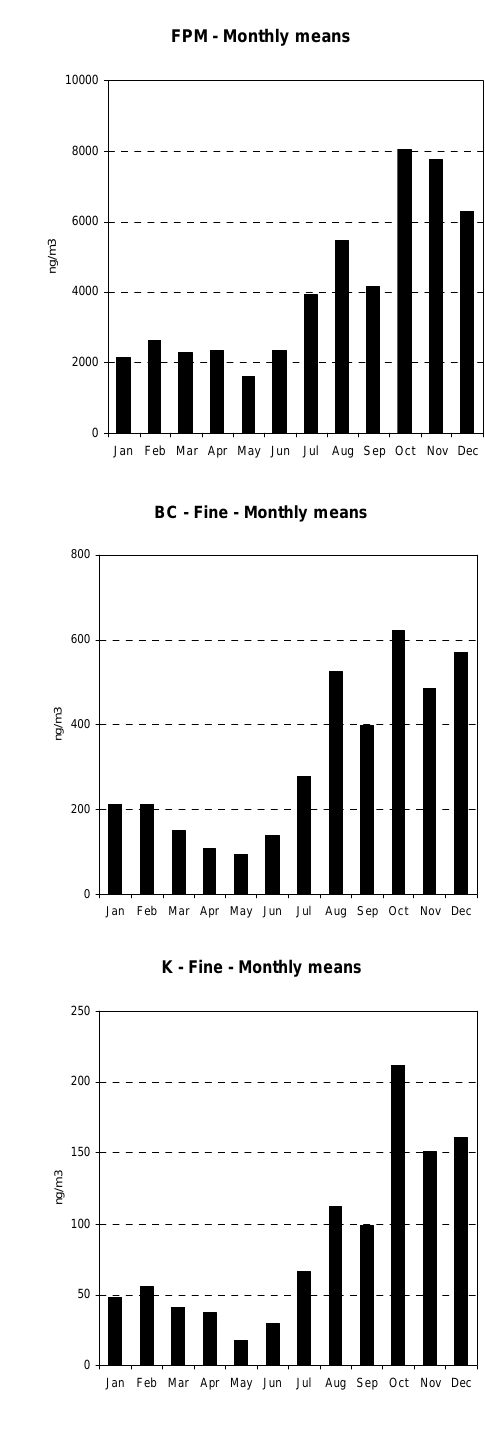
Fig. 6. Monthly means of coarse mode (left) and fine (right) particulate, black carbon equivalent and elemental mass